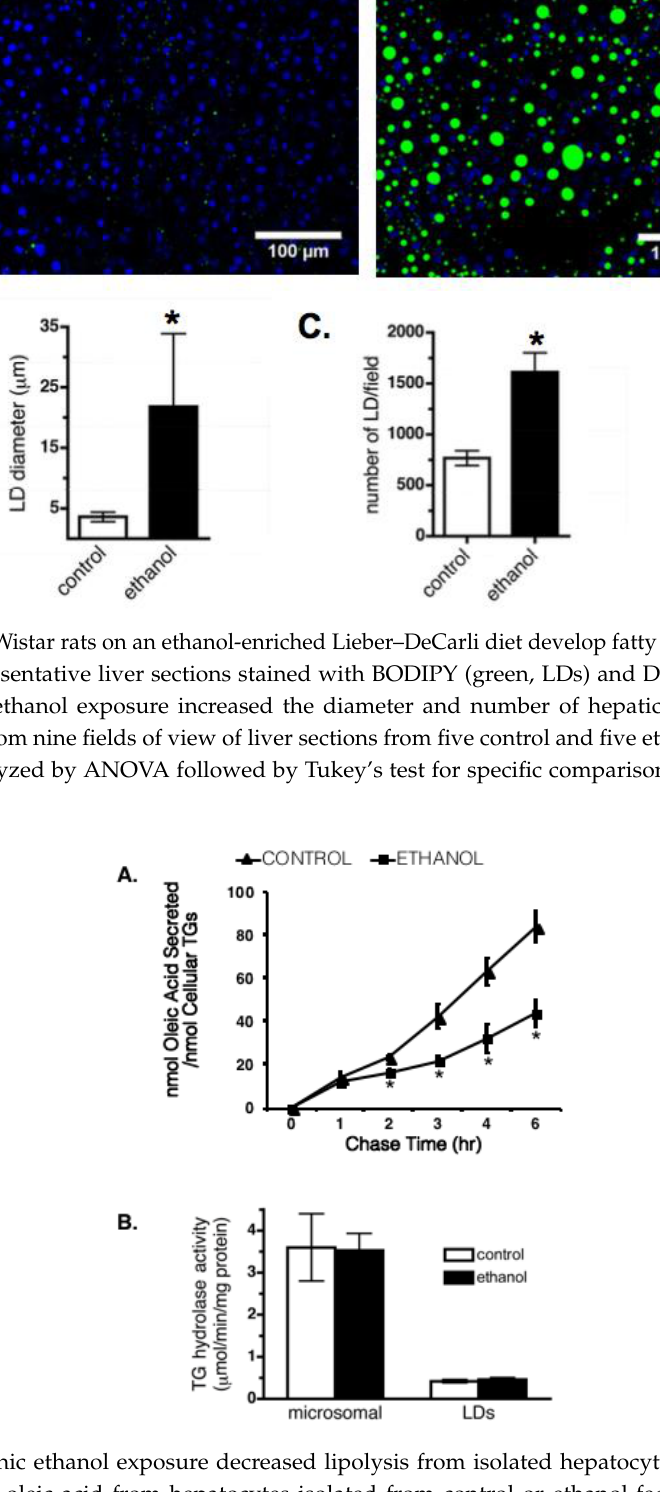
Figure 2. Chronic ethanol exposure decreased lipolysis from isolated hepatocytes. ( A ) The efflux of radiolabeled oleic acid from hepatocytes isolated from control or ethanol-fed rats. Values are mean ± SEM (*, p < 0.05; n = 5). ( B ) Triacylglycerol hydrolase (TGH) activity in microsomal and lipid droplet (LD)